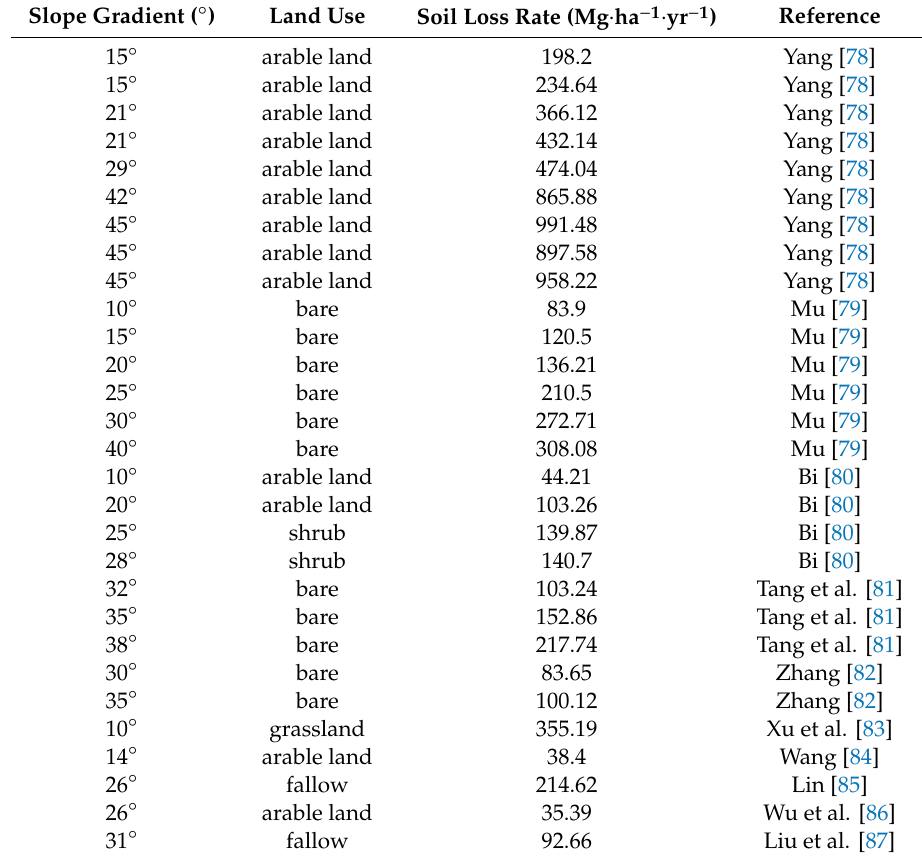
Table A1. Measured soil erosion